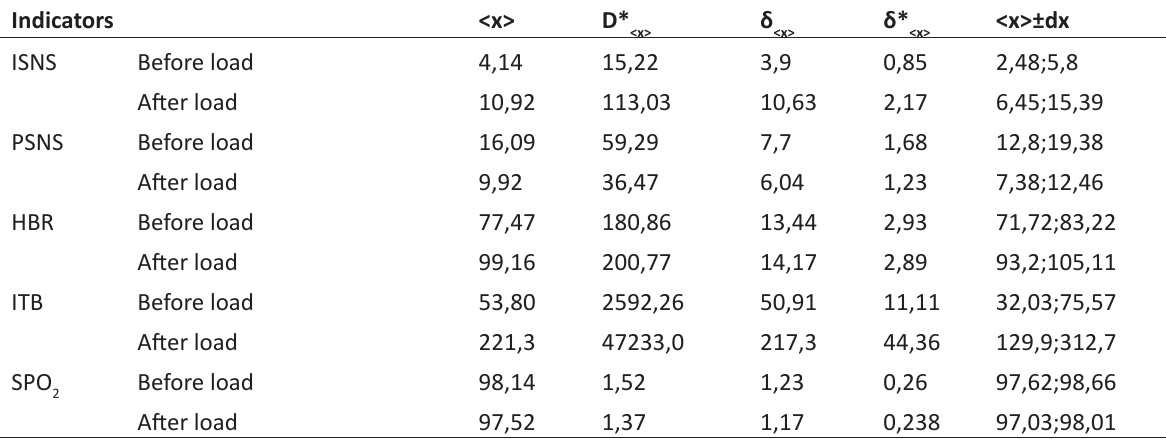
Table 5. Cardio-respiratory indicators of 3 rd group boys’ functional system before and after physical load